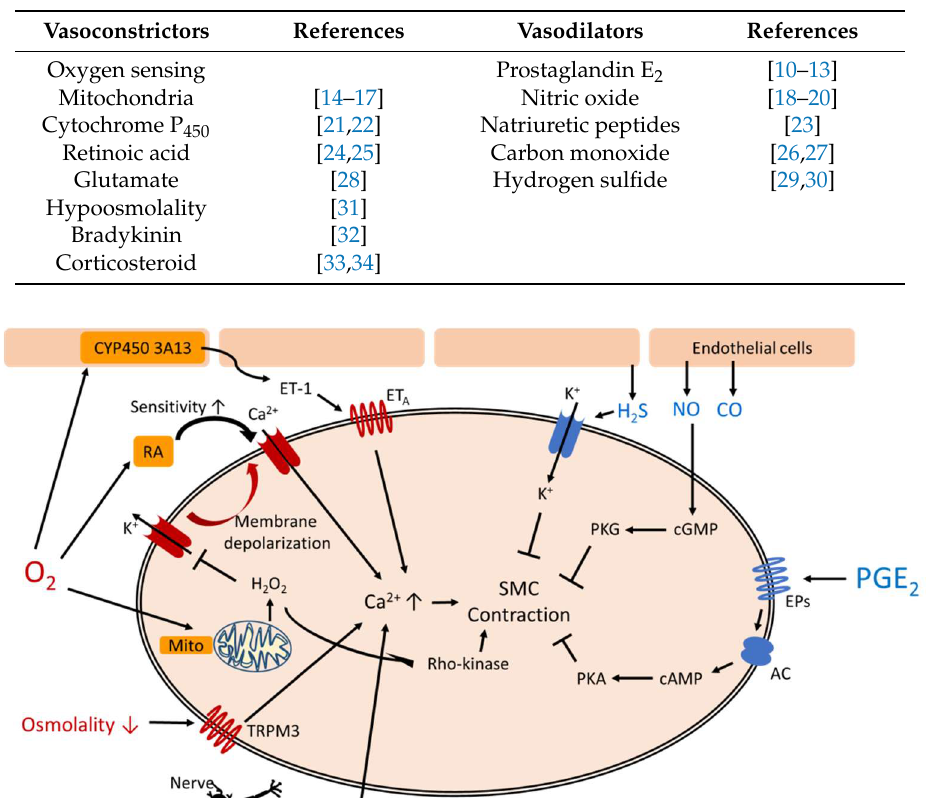
Table 1. Factors mediating functional closure of the ductus arteriosus.